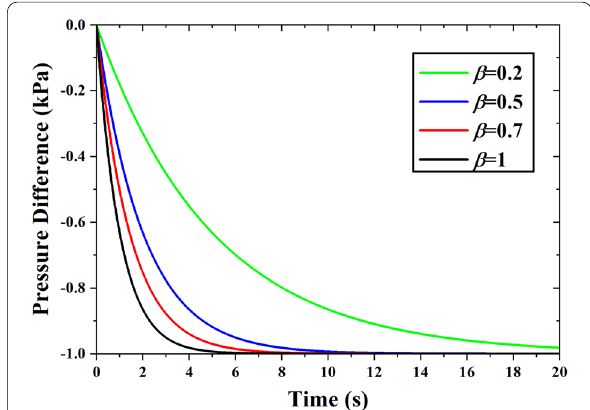
Figure 2 Relationship of β and pressure difference without leakage